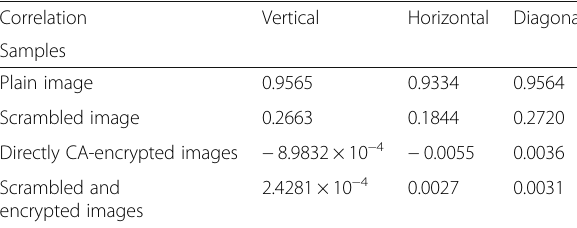
Table 7 Correlation detection results for the cameraman picture